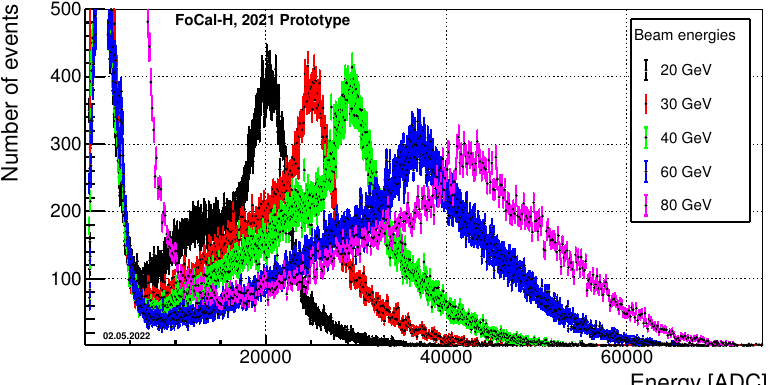
Figure 3. Reconstructed charge in the FoCal-H prototype in ADC counts as a function of the beam particles energy for beam energies from 20 GeV to 80